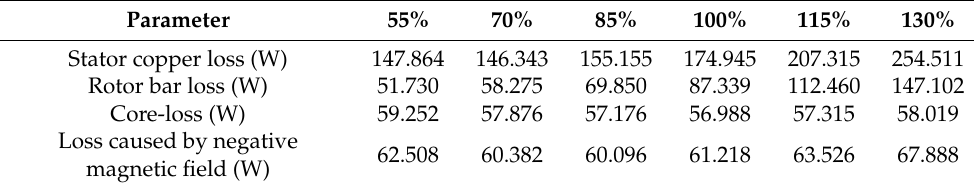
Table 5. The comparison of electromagnetic losses at different